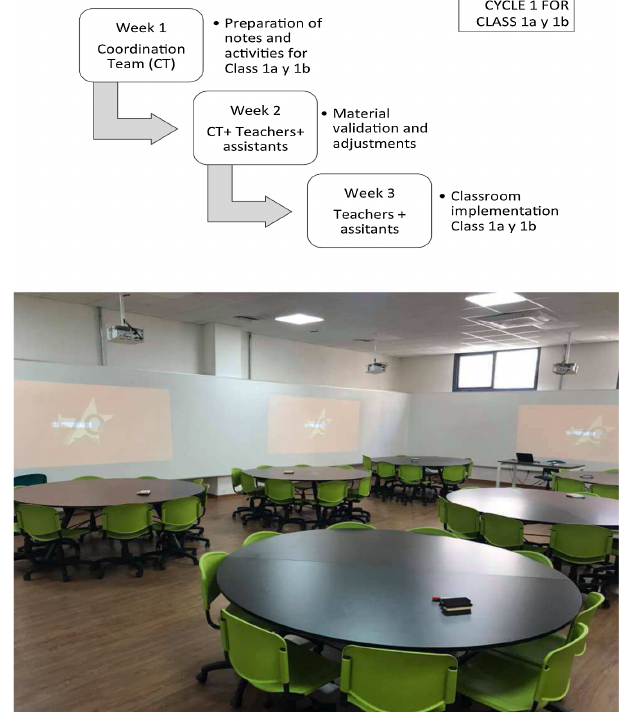
FIG. 1. Top: Work cycle. Bottom: Student centered